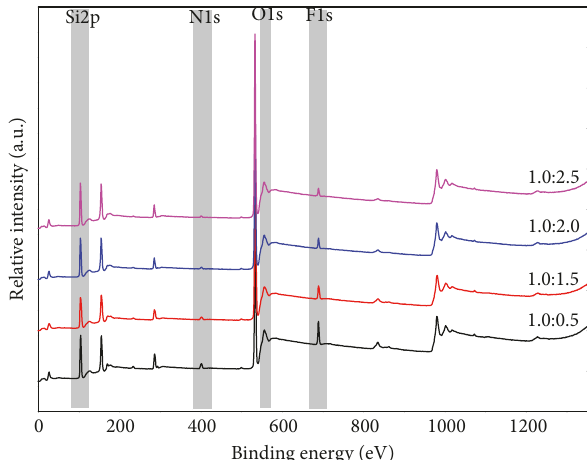
Figure 3: XPS spectra of ionic liquid modified silica particles.